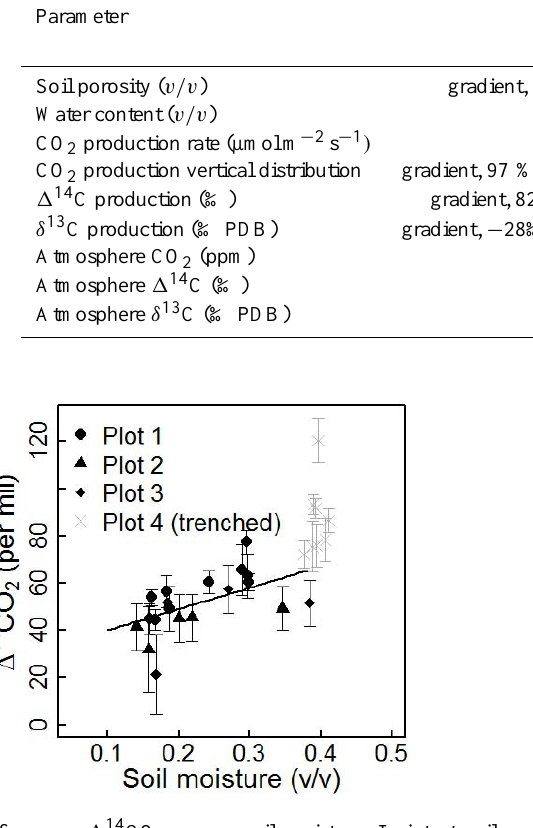
Fig. 5. Time series of (a) soil CO 2 flux measured with forced- diffusion probes, (b) soil temperature at 5cm, and (c) volumetric soil moisture at 4cm. The mean of the three intact plots is shown for